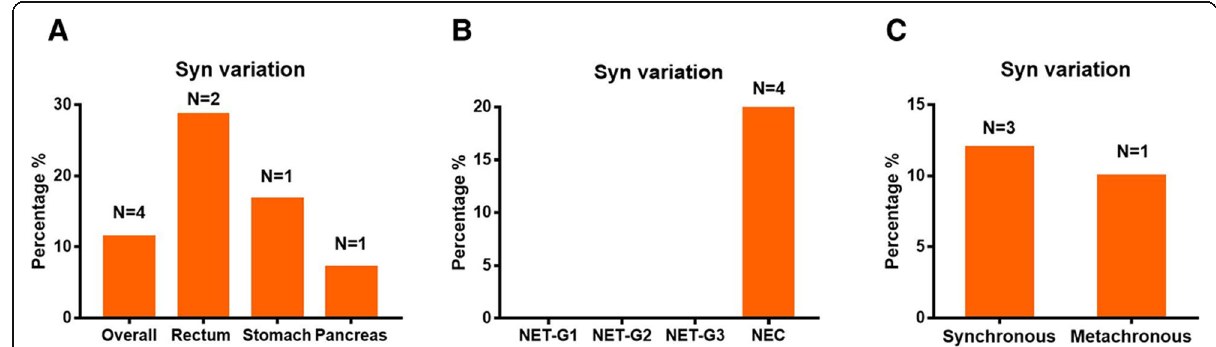
Fig. 3 Percentages of patients with Syn-variation at different primary tumor sites ( a ). Percentages of patients with Syn-variation under different classifications of NENs ( b ). Percentages of patients with Syn-variation under different types of metastatic tumors ( c